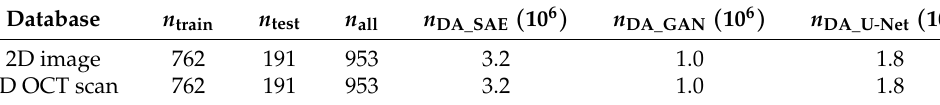
Table 1. Dataset for 3D